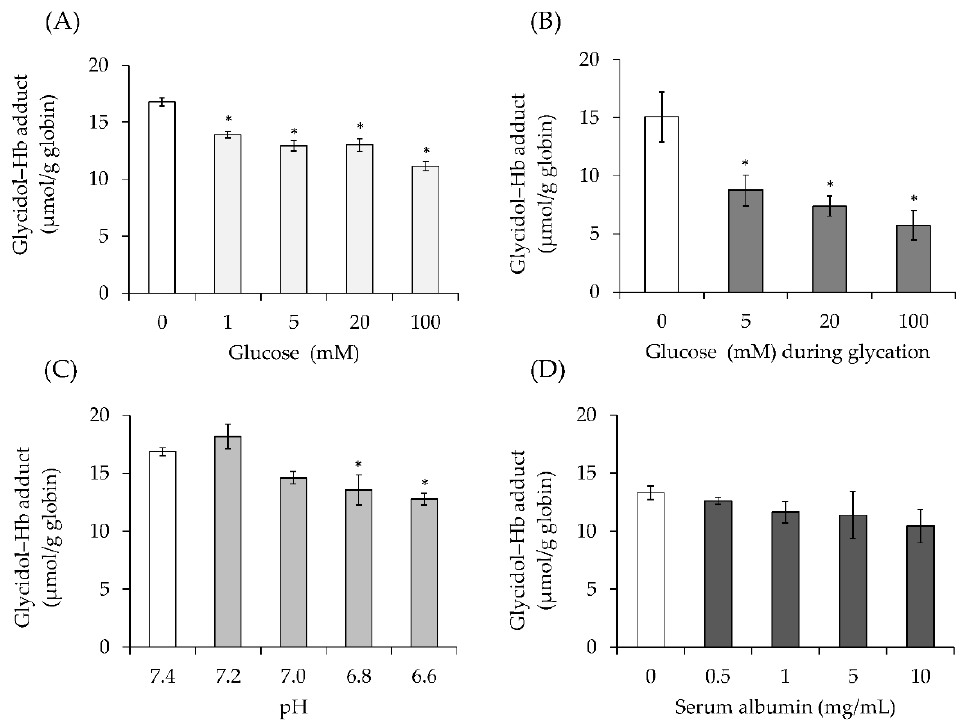
Figure 3. Effect of the factors on glycidol – hemoglobin (Hb) adduct formation (in vitro). Effect of ( A ) glucose, ( B ) glycated Hb, ( C ) pH, and ( D ) serum albumin on glycidol – Hb adduct formation. Each solution was dissolved in 0.1-M phosphate buffer (pH 7.4) and reacted at 37 °C for 18 h using a shaker. After FITC derivatization of the reaction solution, the glycidol – Hb adduct was measured by LC-MS/MS. The values represent the mean standard deviation (SD) of four independent experi- ments. * The significance level was p < 0.05 compared with glycidol (no additives, pH 7.4).